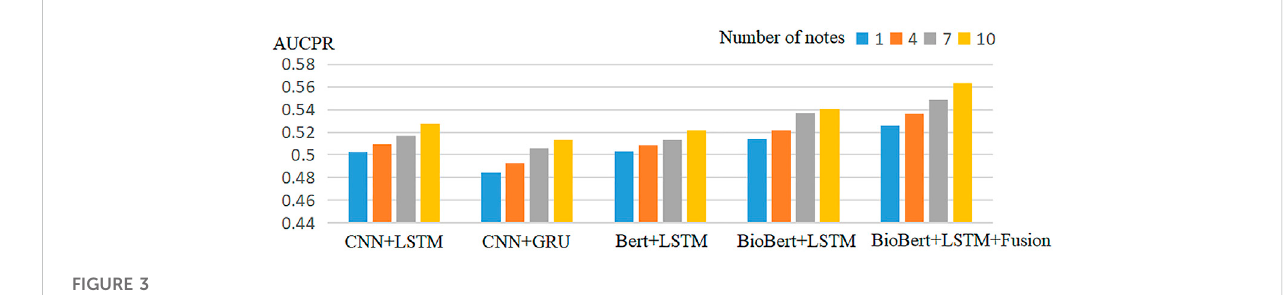
FIGURE 3 Models ’ robustness comparison of AUCPR.